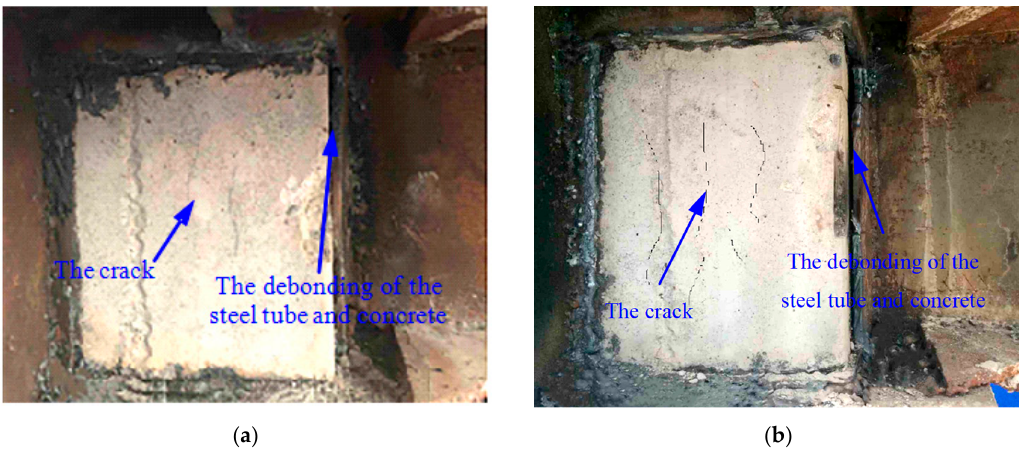
Figure 11. Damages to the joint specimens (cut-away view). ( a ) Specimen JD-1; ( b ) Specimen JD-2.